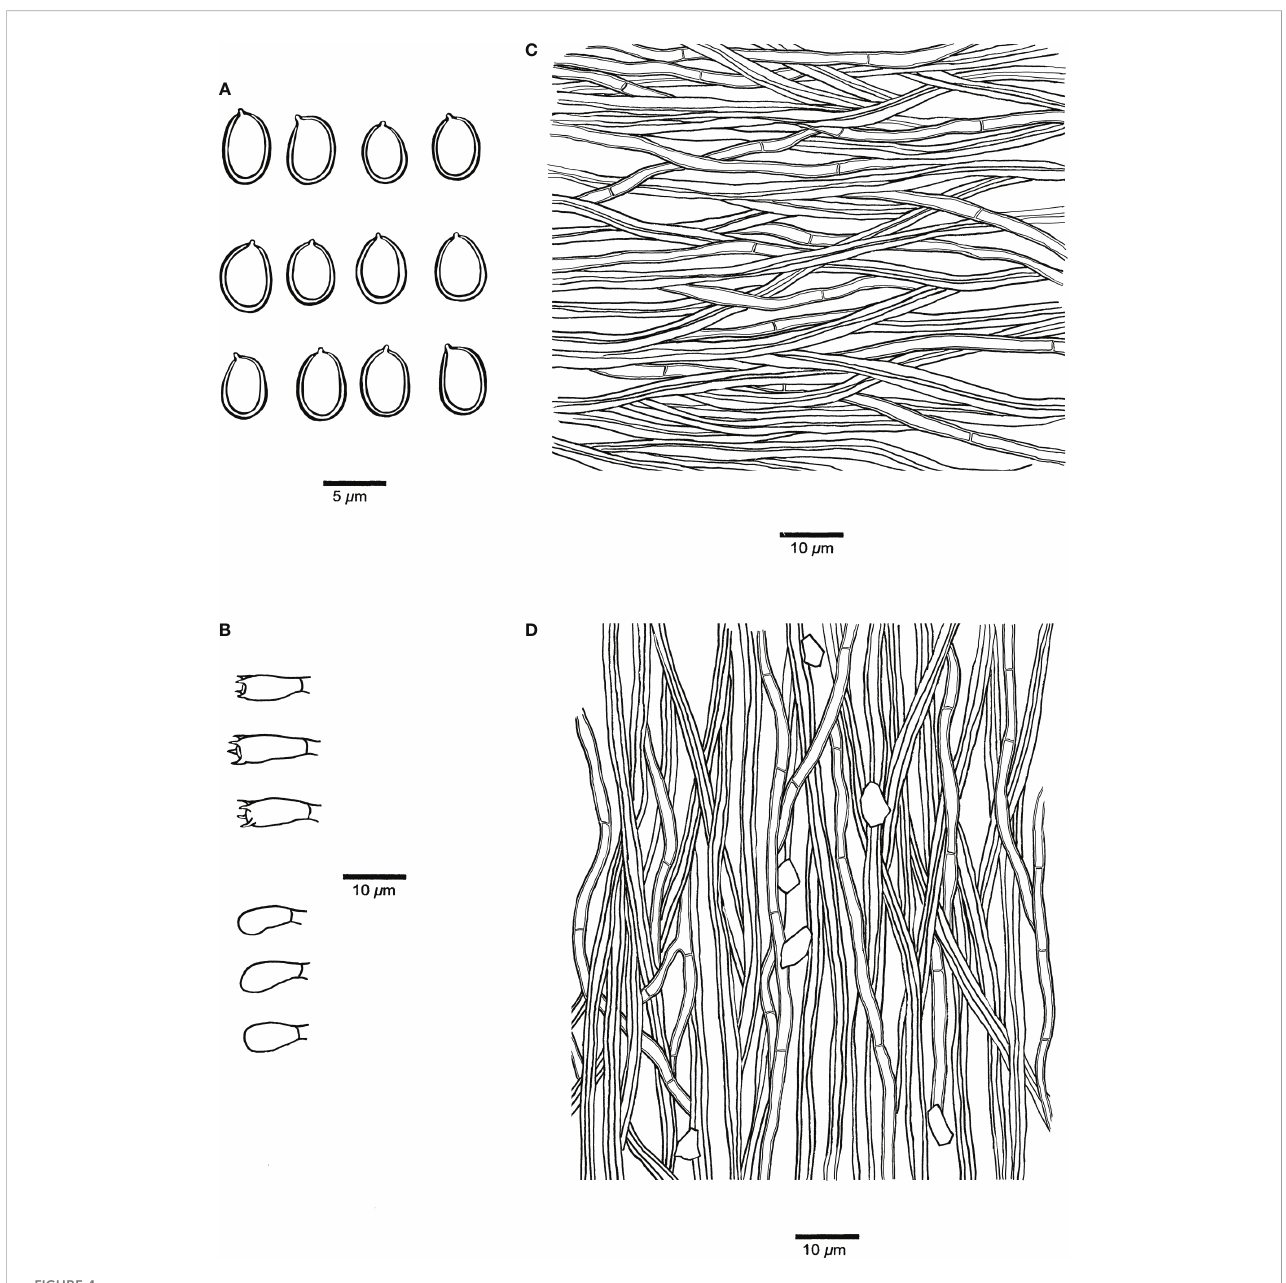
FIGURE 4 Microscopic structures of Fulvifomes acaciae (JV 0312/23.4-J). (A) Basidiospores. (B) Basidia and basidioles. (C) Hyphae from context. (D) Hyphae from tube